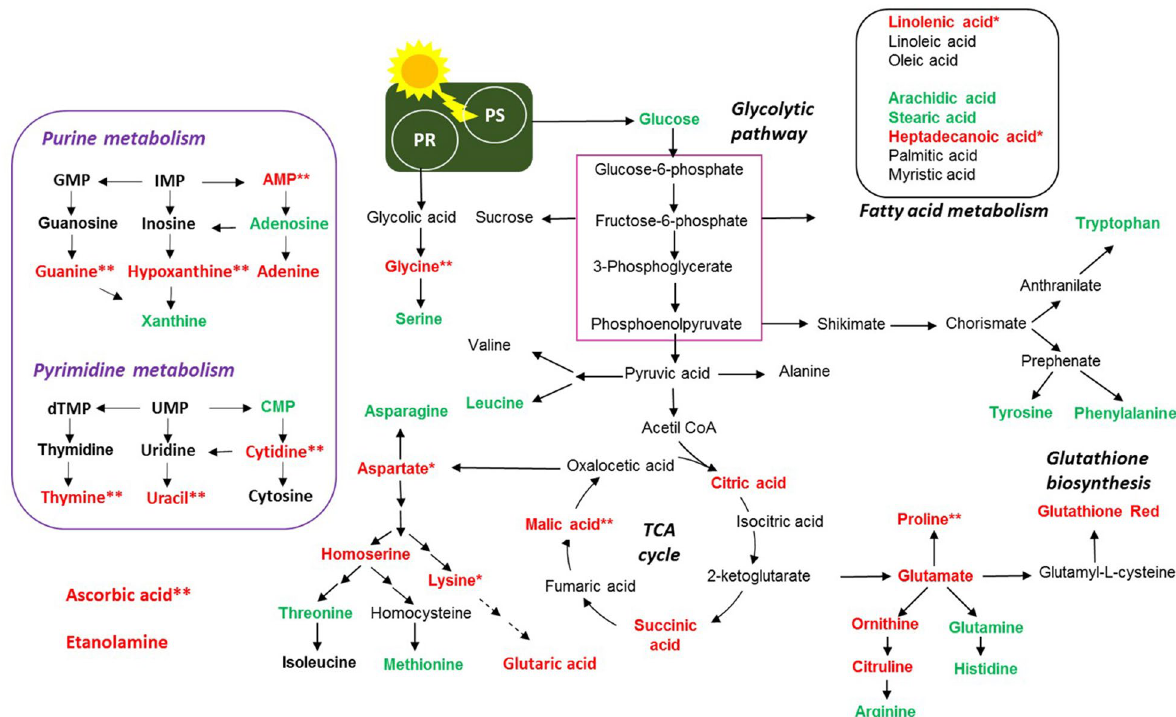
Figure 6. Overview of the proposed perturbations in metabolic pathways in golden-brown alga P. malhamensis exposed to 1 mg L −1 AgNPs and 40.7 μg L −1 AgNO 3 , corresponding to the dissolved Ag in AgNPs suspension, for 2 and 24 h. Accumulated and depleted metabolites are present in red and green colors. *denotes perturbations observed at 24 h-exposure only; **denotes perturbations observed at 2 h-exposure only, PS photosynthesis, PR photorespiration. Only significantly altered metabolites (Supplementary Table S1; Supplementary Fig. S1) were considered. Data were normalized by using probabilistic quotient normalization by untreated control group at time 0 (C0), log transformed and